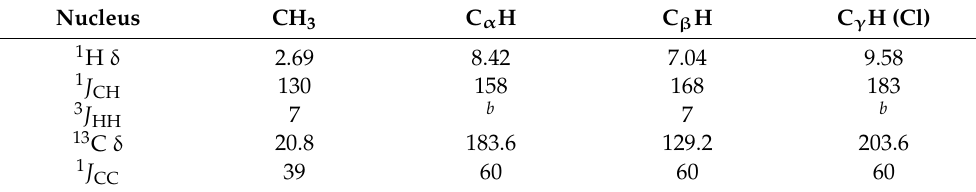
Table 4. NMR data a for cation VII in a SO 2 ClF solution.